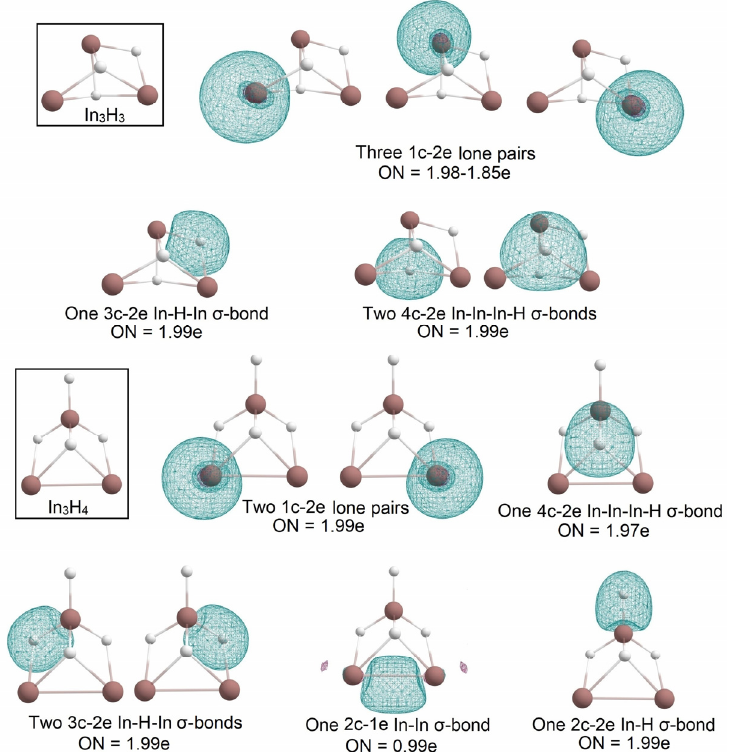
Figure 9. The chemical bonding pattern of In 3 H 3 and In 3 H 4 obtained by AdNDP analysis. As in the case of In 2 H 4 and B 2 H 4 , the global minimum structures of In 3 H 5 and B 3 H 5 [4] are different. Both systems are presented in Figure 10. B 3 H 5 has three 2c-2e B-H terminal σ -bonds, two bridged B-H-B σ -bonds, and three B atoms that are bonded via 3c-2e B-B-B σ -bond and a 3c-2e B-B-B π -bond, so there are no 1c-2e lone pairs again. In In 3 H 5 , two indium atoms save 1c-2e lone pairs; there is one In-H 2c-2e terminal σ - bond with ON = 1.99e, three bridged 3c-2e In-H-In σ -bonds with ON = 1.98–1.97e, and one 4c-2e In-In-In- H σ -bond with ON = 1.96e (Figure 11). Thus, for boron clusters, aromaticity is found for both saturated and non-saturated structures [21], but for indium, we observed aromaticity only for the most unsaturated hydrides. It is another demonstration of the difference be- tween the patterns of boron and indium hydrides. Figure 10. The comparison of the global minimum structures for ( a ) B 3 H 5 (according to [4]) and ( b ) In 3 H 5 . The low-lying classical In 3 H 5 structure (Figure 11) is about 17.2 kcal/mol higher than the global minimum structure; this corresponds to the trend previously observed for